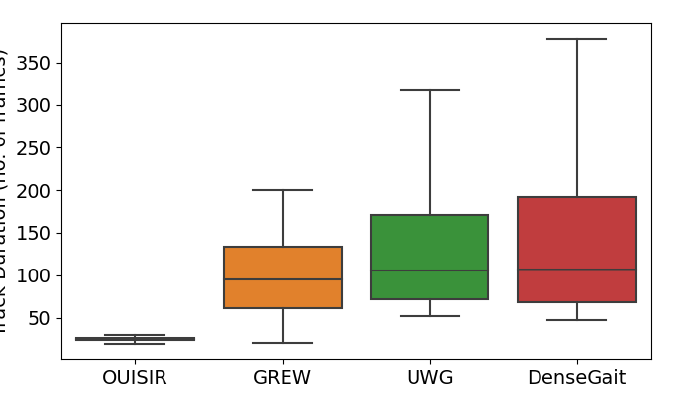
Figure 1. Comparison between existing large-scale skeleton gait databases and DenseGait in terms of distributions of tracklet duration. DenseGait is an order of magnitude larger than the next largest skeleton database, while having a longer average duration (136 frames UWG vs 162 frames